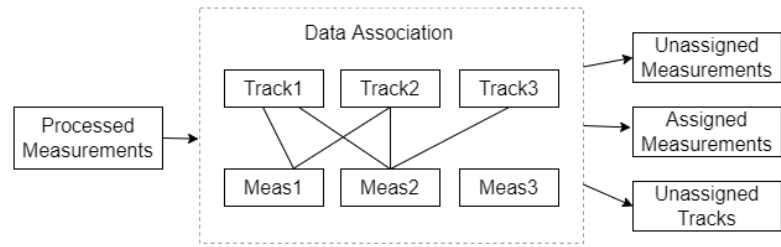
Figure 8. Data Association Results.